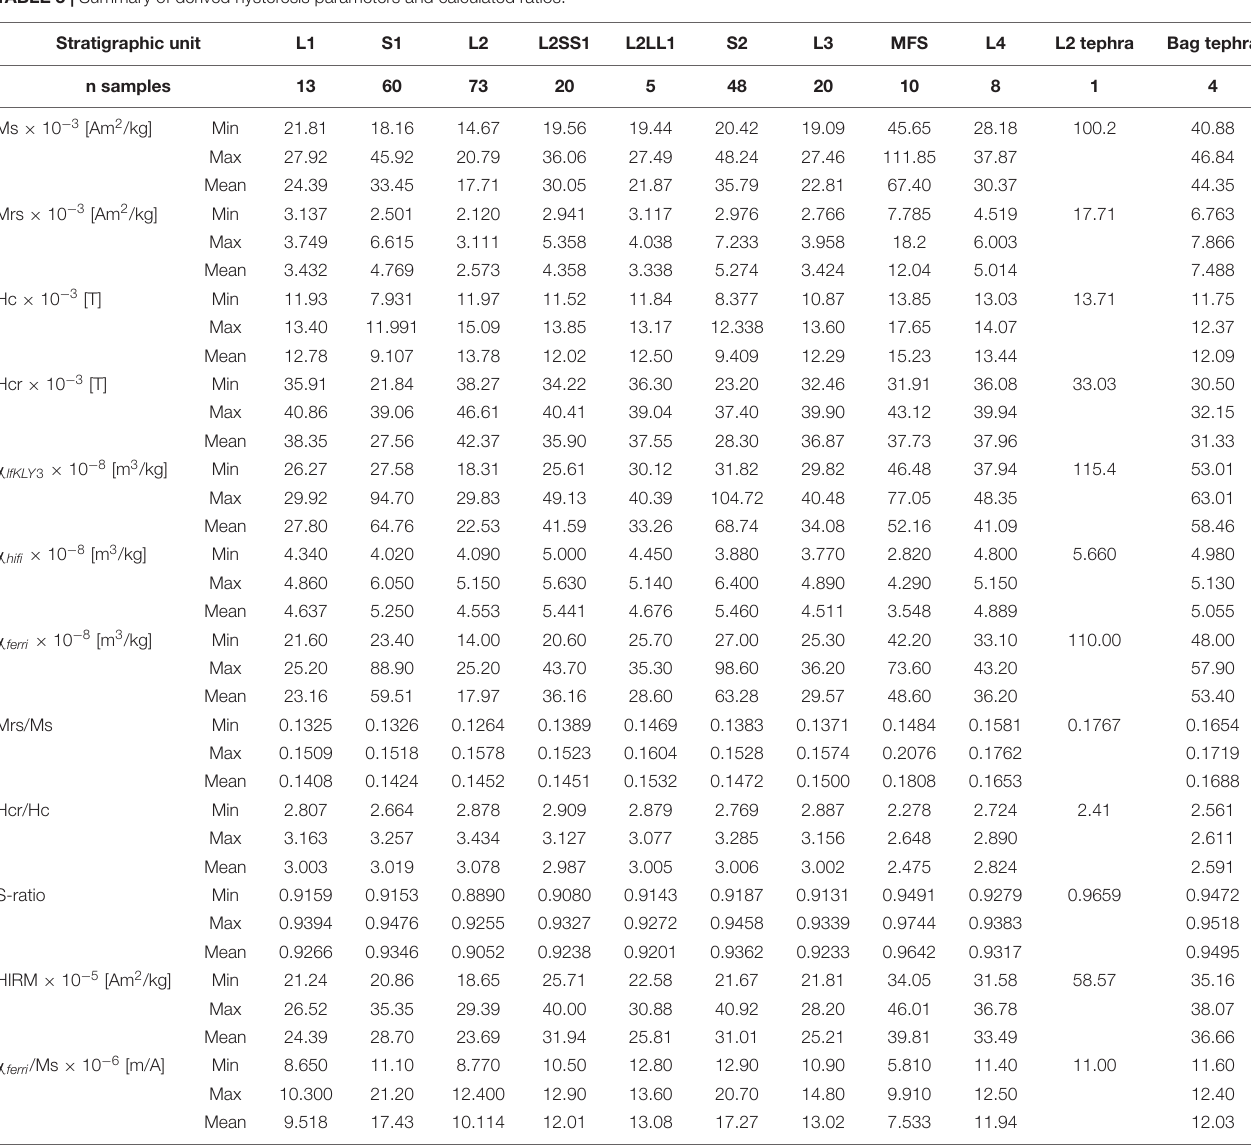
TABLE 3 | Summary of derived hysteresis parameters and calculated ratios. Stratigraphic